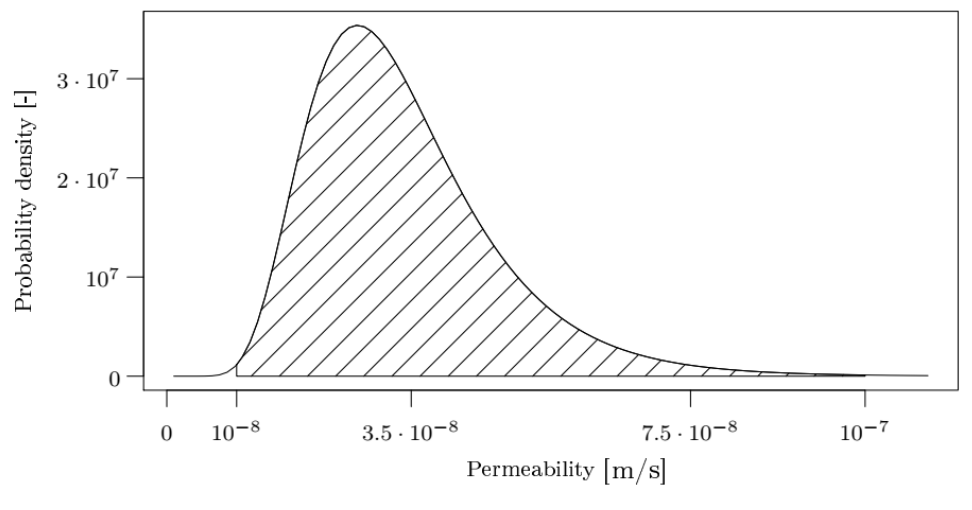
µ = σ = 0.38. The 17.26 and − 10 − 8 ,10 − 7 amounts to 0.99. (cid:98) (cid:98) (cid:2) (cid:3)